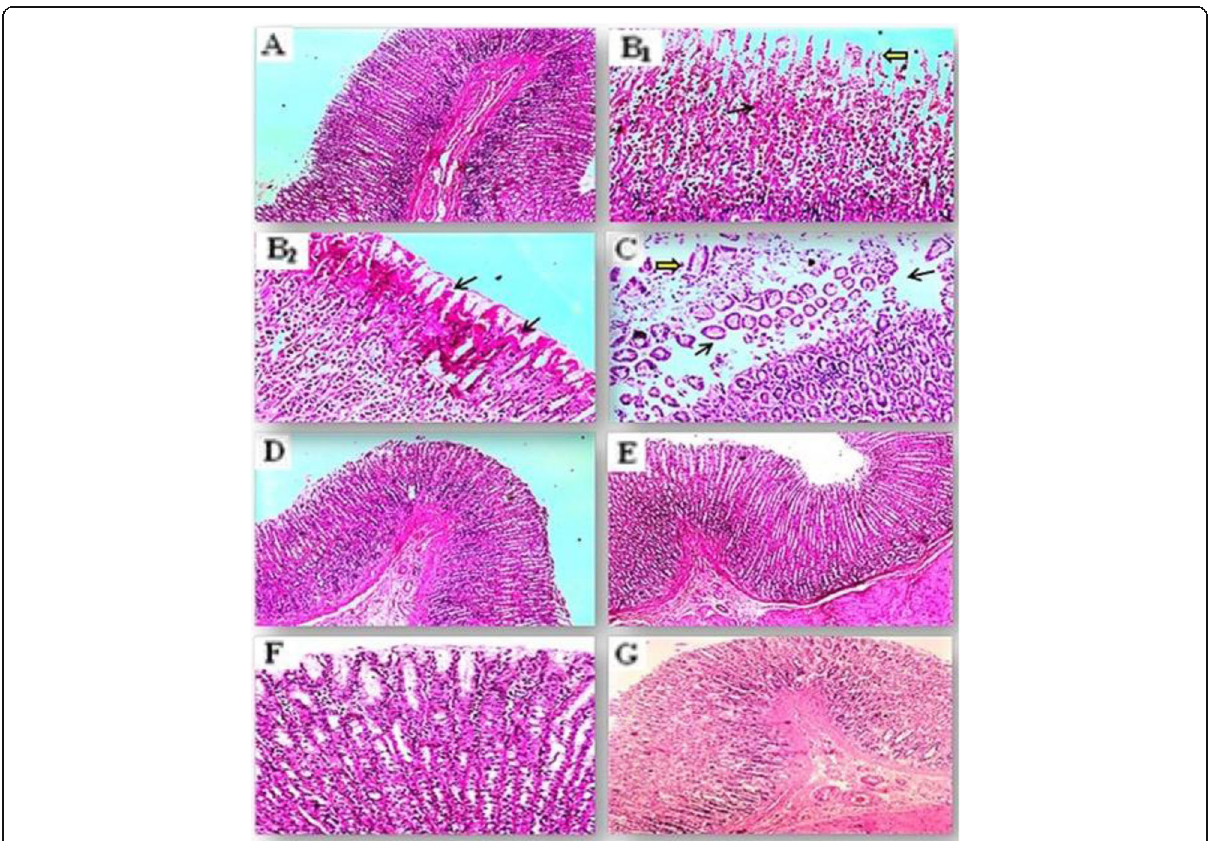
Fig. 7 Photomicrograph from stomach tissues for the protective effects of C. ignea aerial parts extract against ethanol induced gastric ulceration in rats. Histopathological tissue sections were stained with H&E stain. In control rats; gastric mucosa showed intact villi with no hemorrhages or exfoliations ( a × 100). EtOH group; showed severe intervillus hemorrhages in gastric mucosa (black arrow) accompanied with severe desquamations in mucous cells (yellow arrow) ( b 1 × 200). Severe coaggulative necrosis in gastric villi (black arrows) was noticed ( b 2 × 200). In Ranitidine group; mucous cell desquamations of gastric villi (yellow arrow) and pyloric glands (black arrows) are pronounced ( c × 100). In C. ignea 250mg/kg and 500mg/kg groups respectively the gastric tissue is histologically normal ( d and f × 100). EtOH + C. ignea 250mg/kg and EtOH + C. ignea 500mg/kg groups; the lining epithelium of the gastric mucosa showed no exfoliations in the mucous cell, also no submucosal hemorrhages ( e and g ×